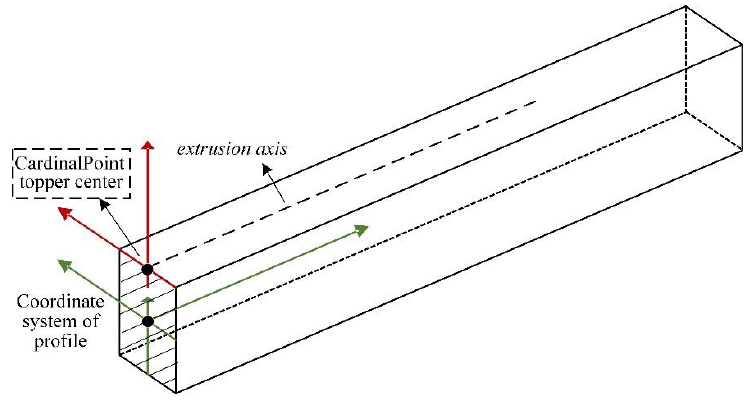
Figure 11. Cardinal point in beam element.